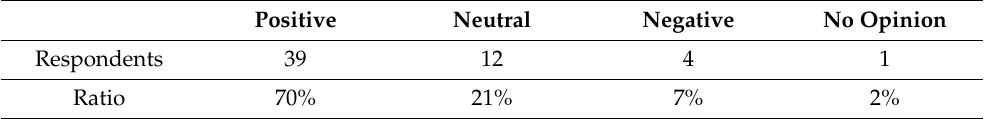
Table 3. Overall opinion of